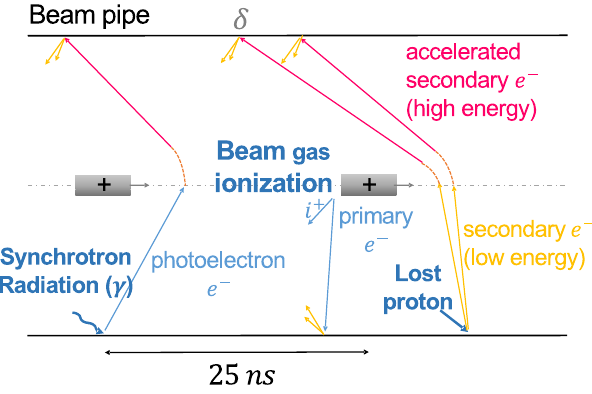
FIG. 2. Schematic of the EC buildup and multipacting process. Synchrotron radiation, beam gas ionization and lost protons generate free electrons. These electrons are accelerated by the beam electromagnetic field and impinge on the opposite beam pipe wall. They can generate secondary electrons depending on the surface